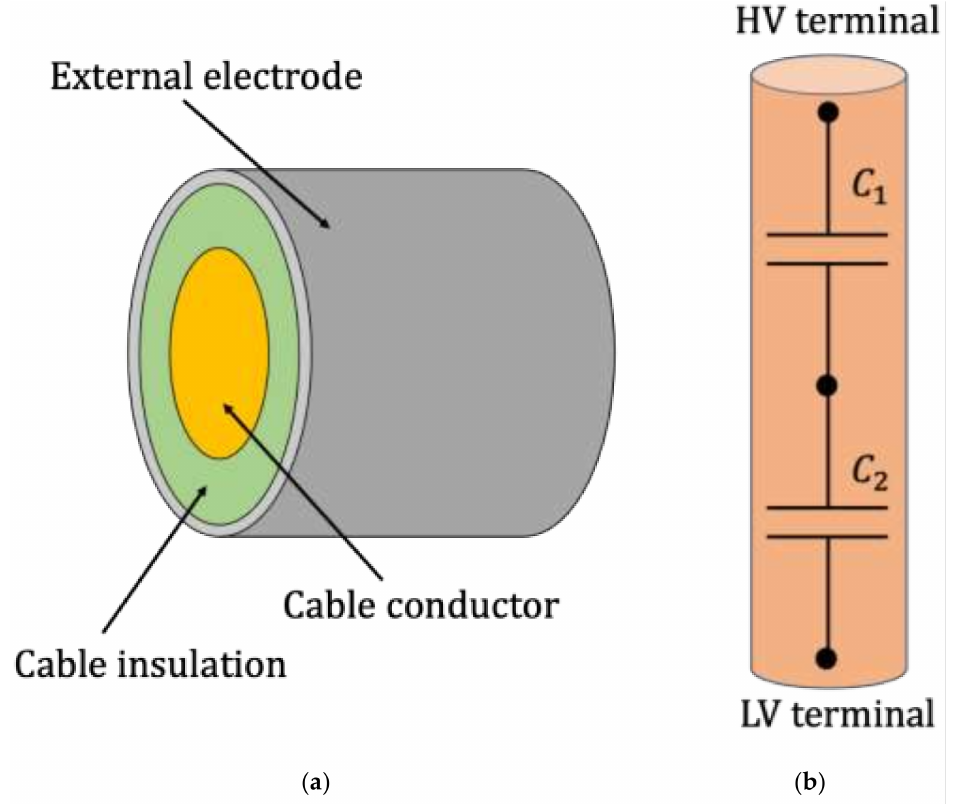
Figure 2. ( a ) Simple representation of a cylindrical capacitive divider. ( b ) Simple representation of a common capacitive